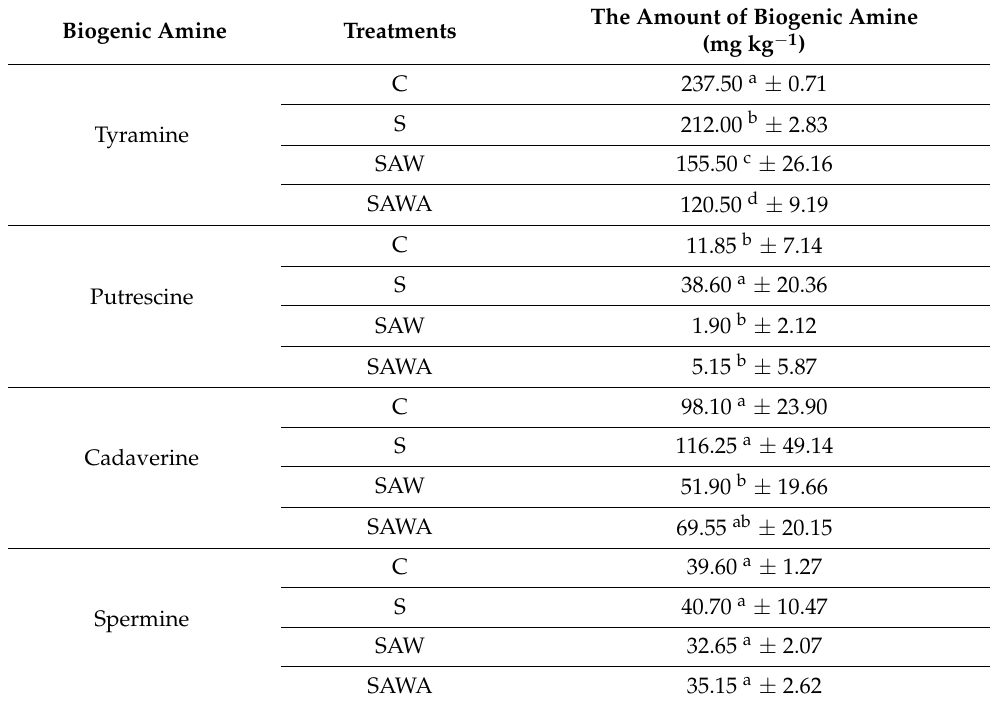
Table 7. Biogenic amines content in dry fermented sausages at the end of manufacturing (21 days) (mean ±